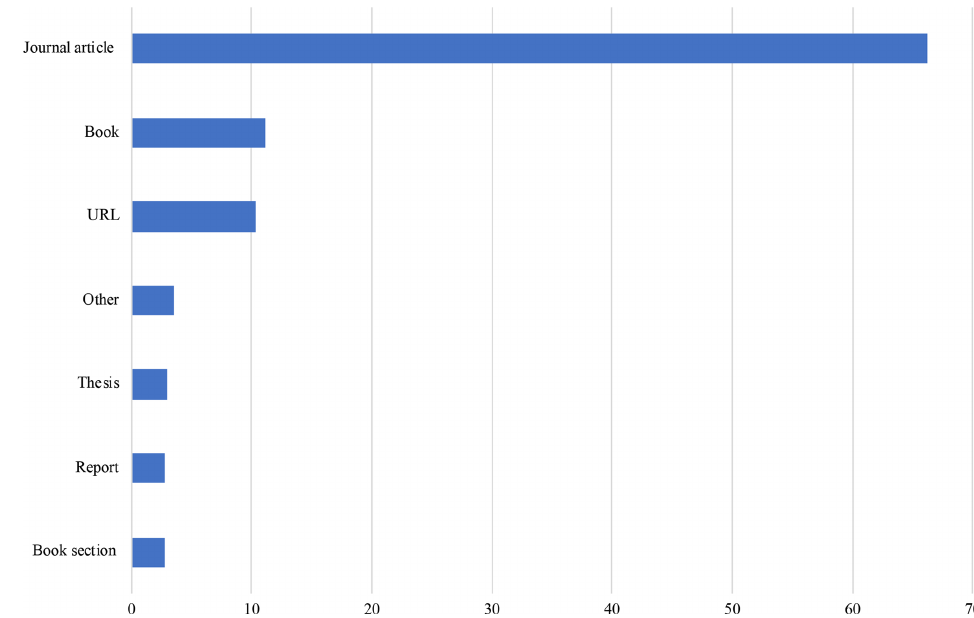
Figure 8. Relative amount (%) of trait source